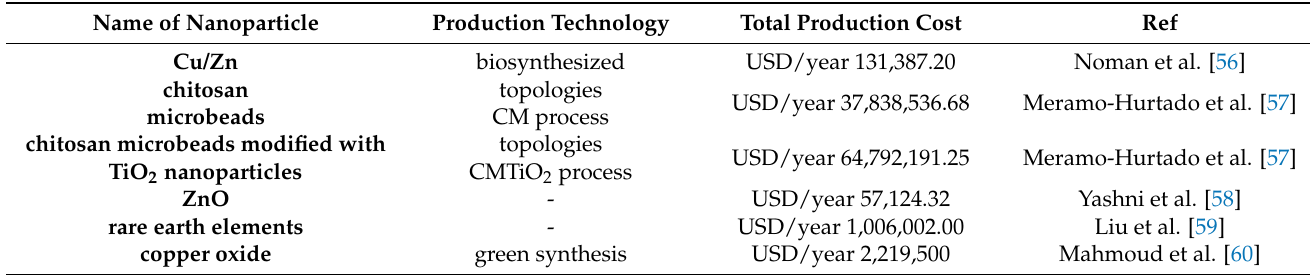
Table 3. Cost of producing different